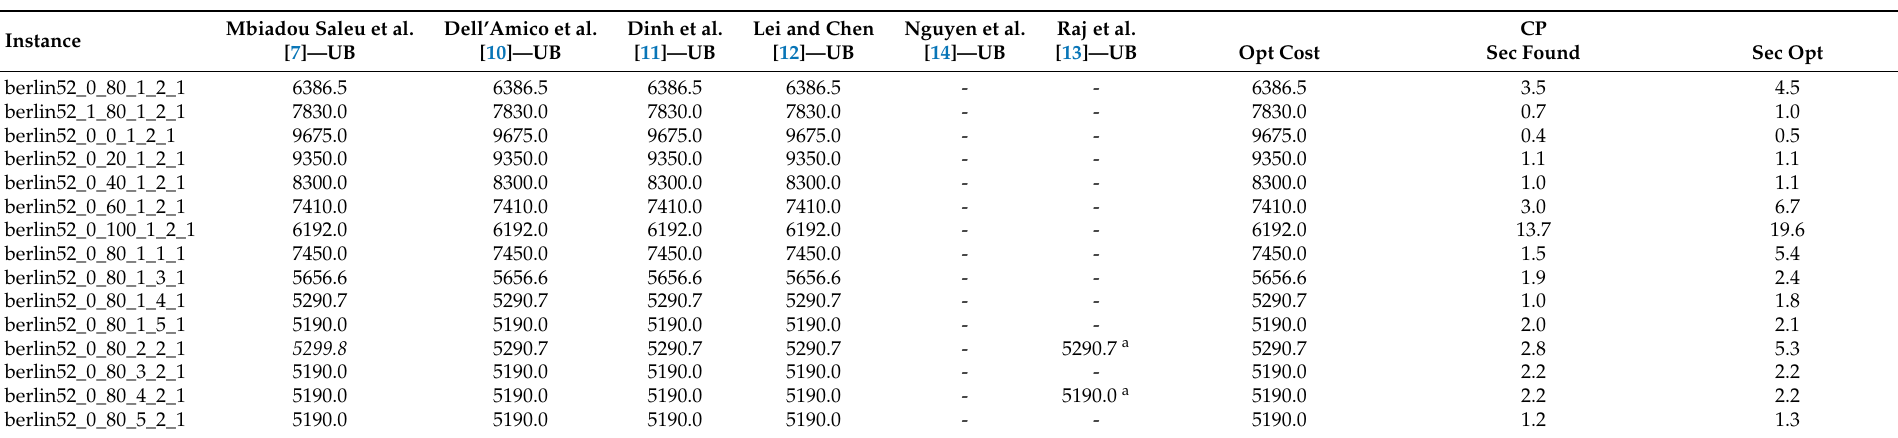
Table 3. Instances originated from berlin52 in [7]. Optimal solution